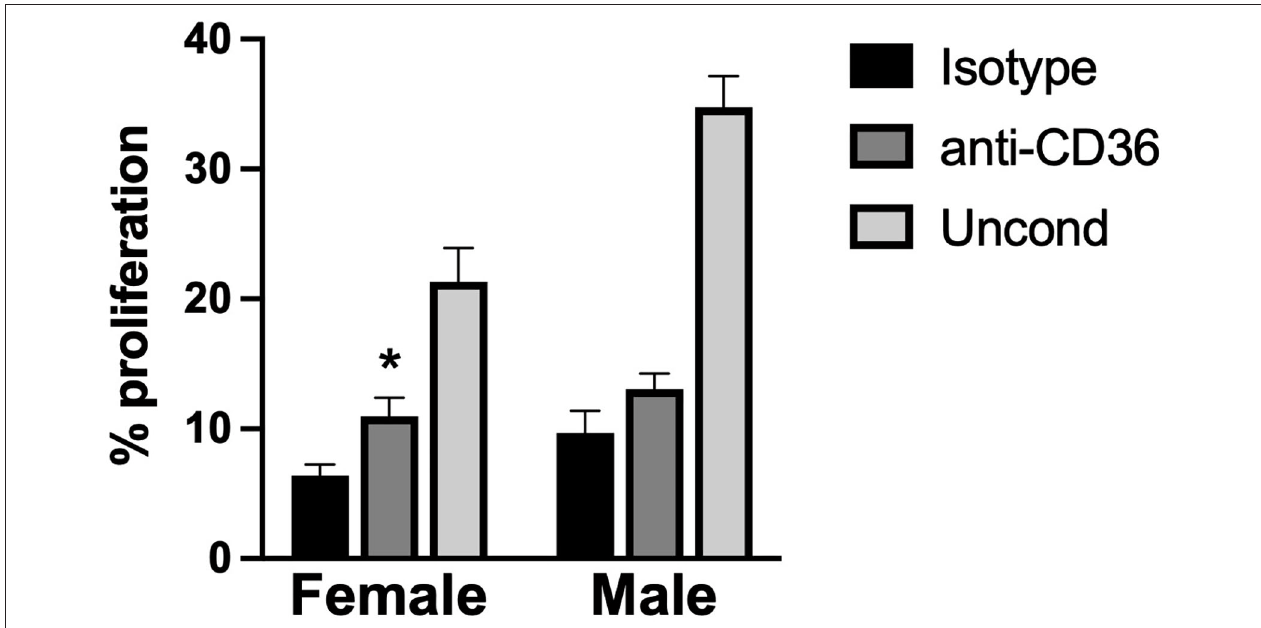
FIGURE 6 | VEC proliferation upon blocking TSP2 in VIC-conditioned media. VEC proliferation was measured following treatment with an antibody against CD36, to block VEC recognition of TSP2, or an isotype control. * p < 0.05 vs. sex-matched isotype control. N = 3 pigs per sex, n = 3 wells per